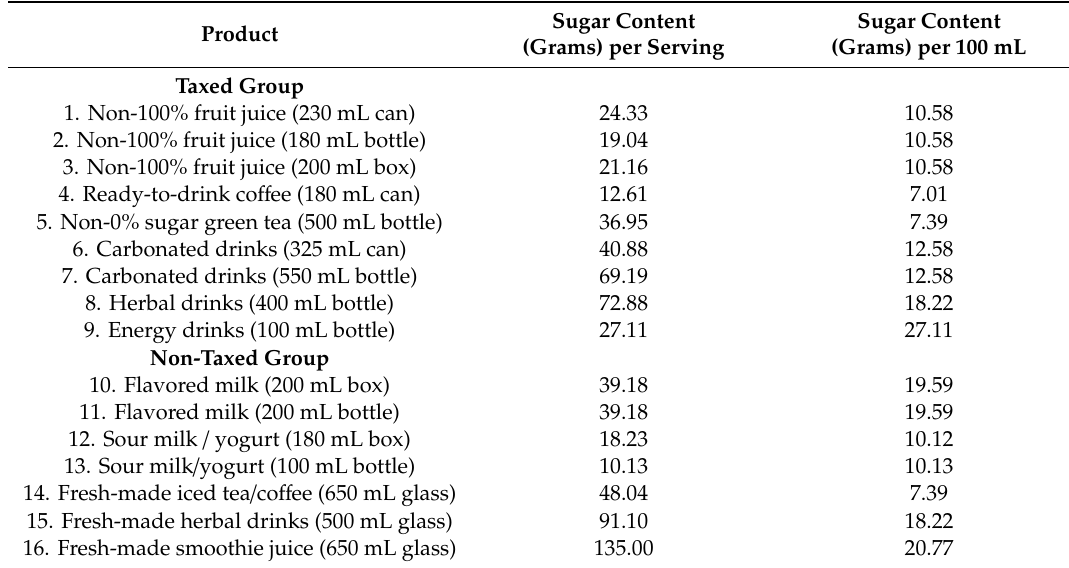
Table 2. Types of specific sugar-sweetened beverage (SSB) products in the study and sugar content of each